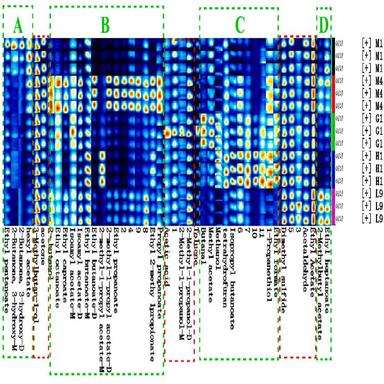
Fingerprinting of volatile components in baijiu.